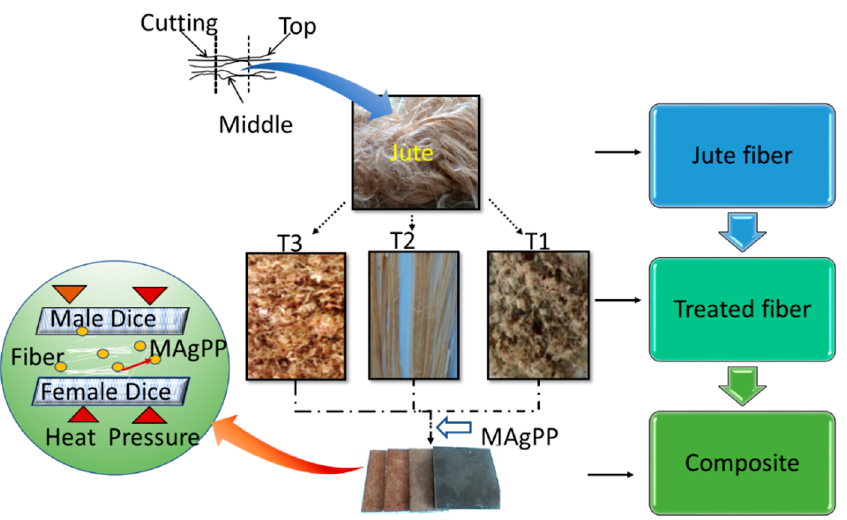
Figure 3. Schematic diagram of workflow for fiber treatment, composite fabrication, and character- ization.